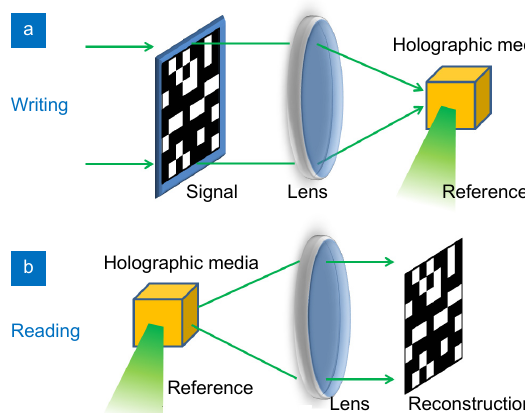
Fig. 1 | Schematic illustration of holographic data storage. ( a ) Writing process. ( b ) Reading process.